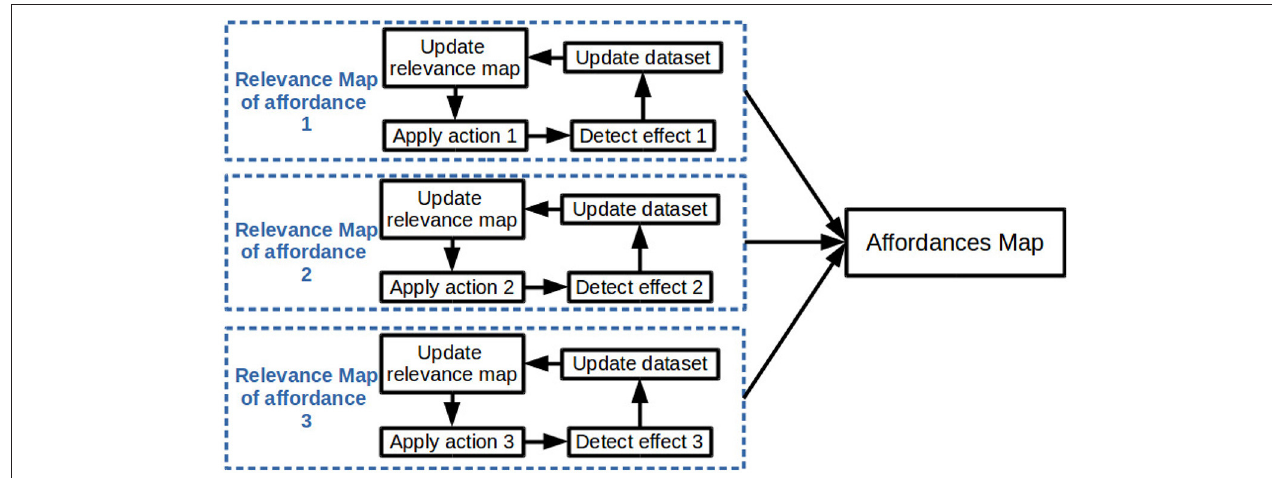
FIGURE 1 | Overview of the general approach to build an affordances